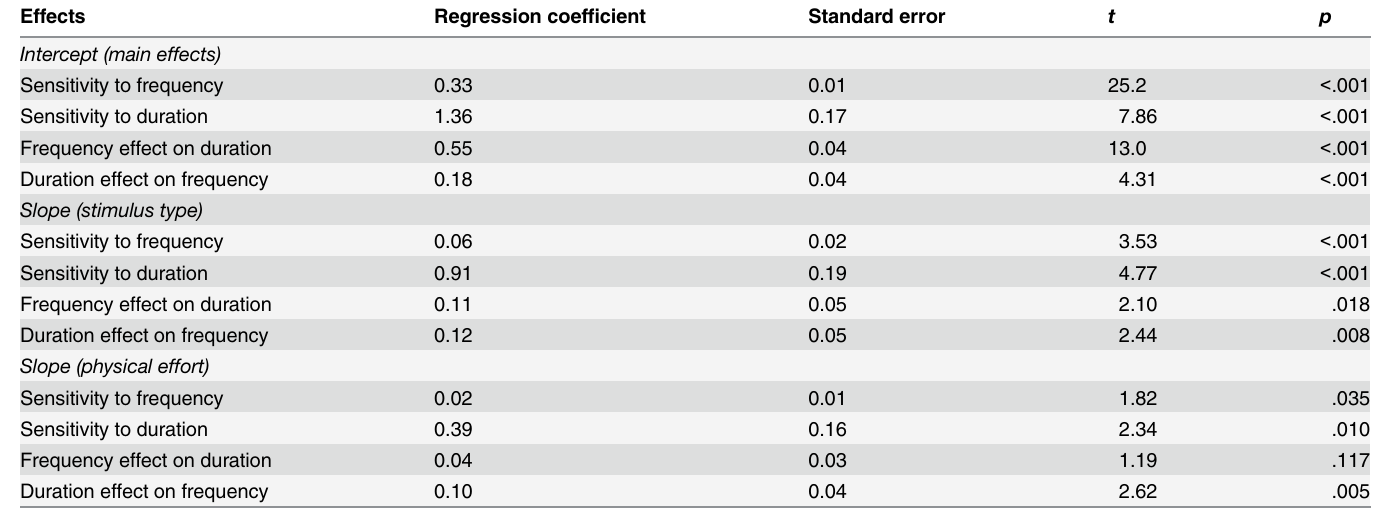
Table 1. Coefficients from the two-level regression model predicting the four main effects of frequency and duration (intercept) and the interac- tions of these effects with stimulus type and physical effort